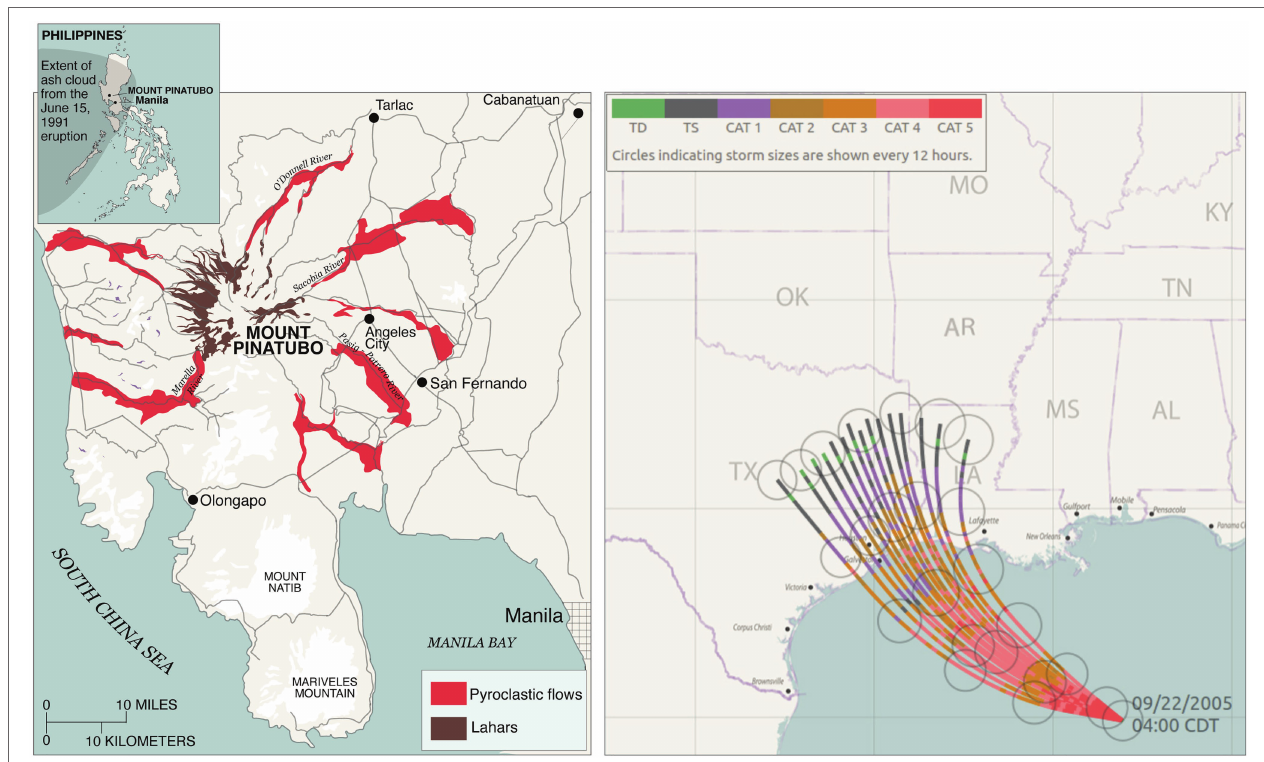
FIGURE 2 | Left, map of Mount Pinatubo pyroclastic flows, lahars, and ash impact areas (redrawn from https://pubs.usgs.gov/fs/1997/fs113-97/). Right, an example of an ensemble hurricane forecast map showing the path, size, and intensity of the forecasted storm along with the associated uncertainties (reprinted with permission from Liu et al.,